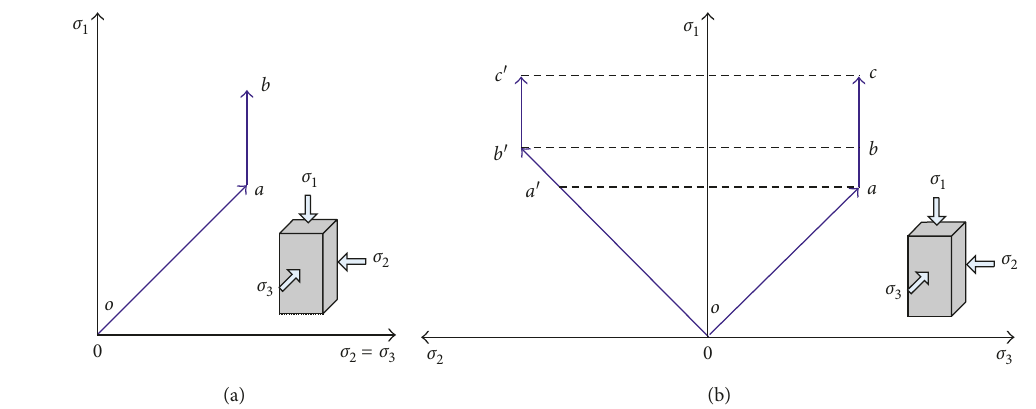
Figure 2: The two different loading programs: (a) CTT; (b)